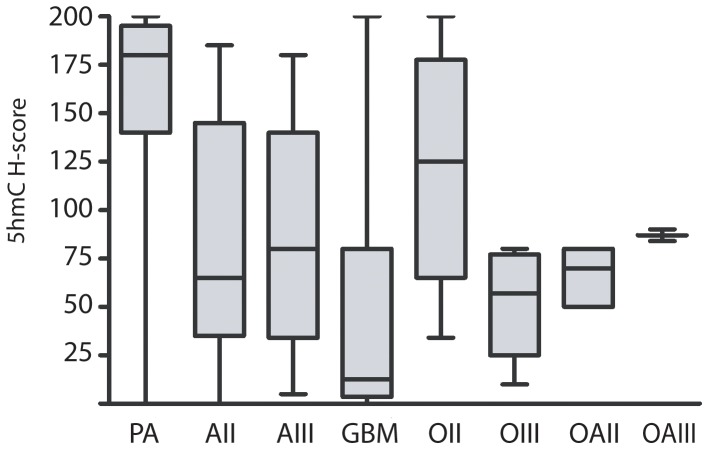
5hmC levels are reduced in glioblastoma.Semi-quantitative intensity scores for 5hmC staining were determined for 225 brain tumors with various histologic diagnoses and grades. Among astrocytic tumors, pilocytic astrocytomas (PA) showed relatively high levels of staining for 5hmC compared to infiltrating astrocytomas. Glioblastoma (GBM) showed significant reduction of 5hmC staining compared to grade II (AII) and grade III astrocytomas (AIII). In oligodendroglial tumors, Grade II oligodendrogliomas (OII) showed high level staining. A reduction in 5hmC levels was observed in grade III oligodendroglioma (OIII). Both grade II and grade III mixed gliomas (OAII and OAIII) showed moderate staining for 5hmC.